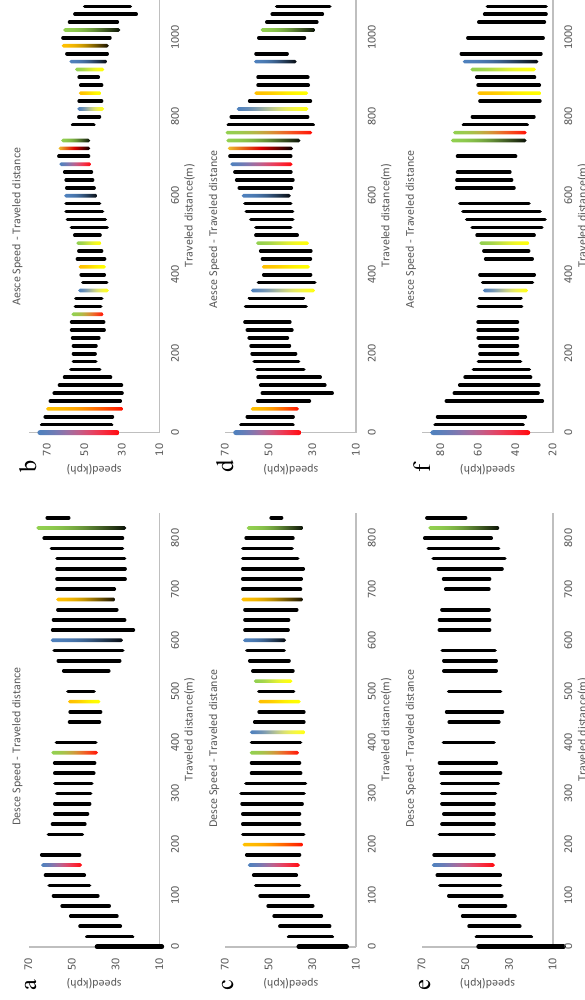
Figure 3 Speed behavior of participants according to MDSI-C